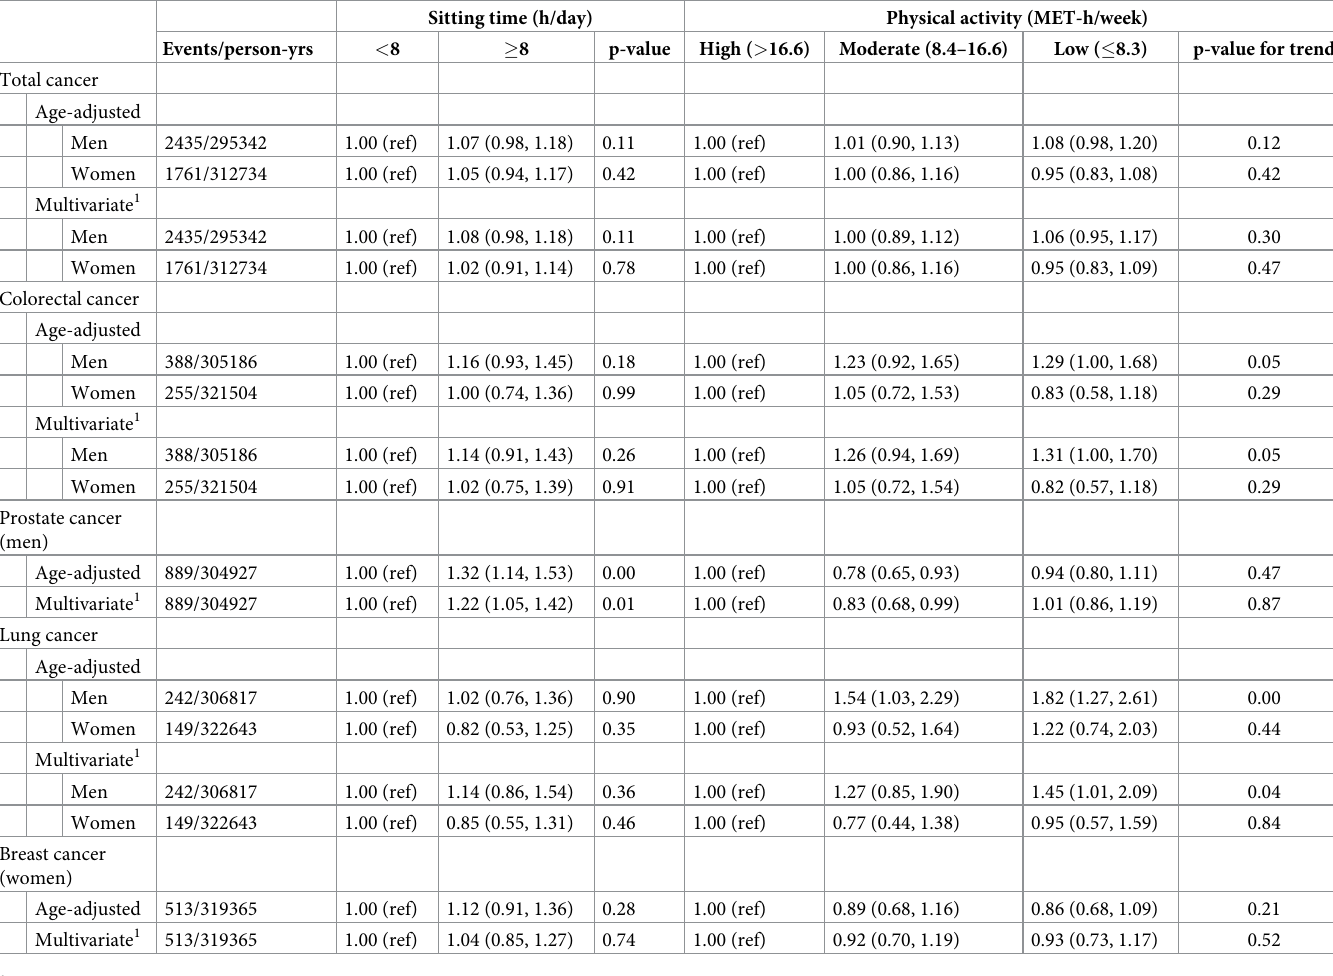
Table 2. Hazard ratios for associations between sitting time, physical activity and total and specific cancer incidence. Sitting time